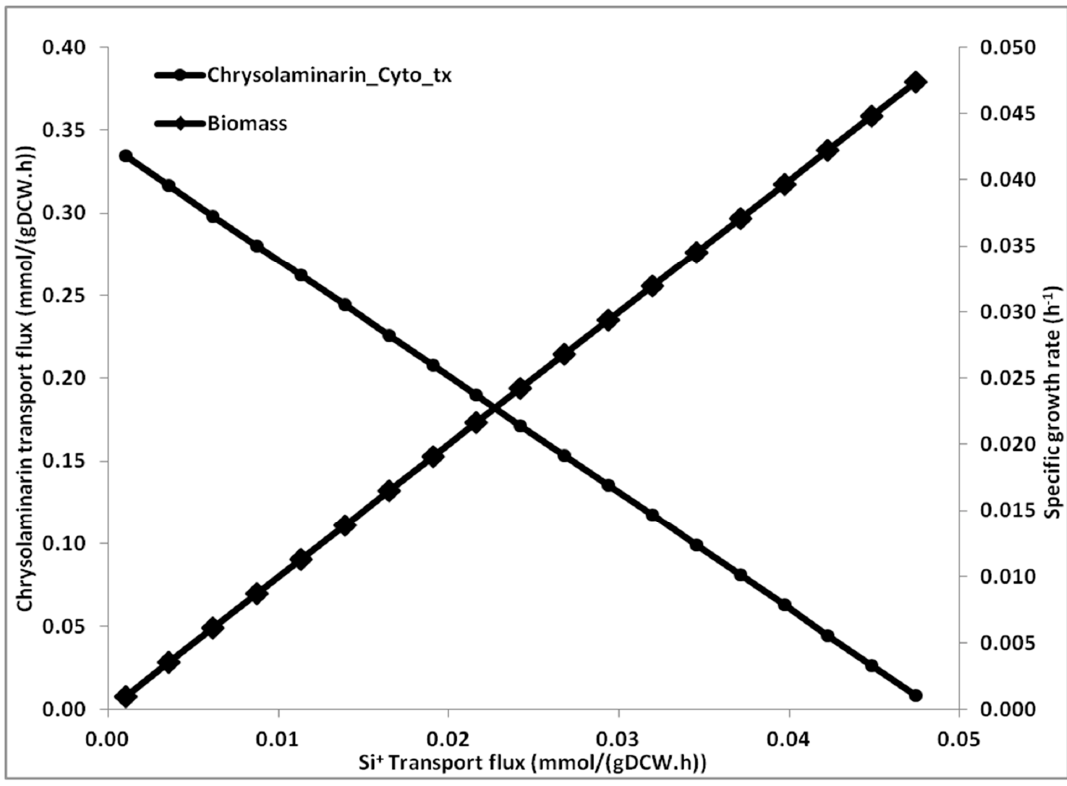
Figure 3. Effect Si + transport variation on biomass and chrysolaminarin production. For these simulations, the Si + -transport was varied from zero to the value obtained under Si + replete condition (0.05 mmol/(gDCW.h) and the fluxes through biomass and chrysolaminarin biosynthesis reactions are presented.